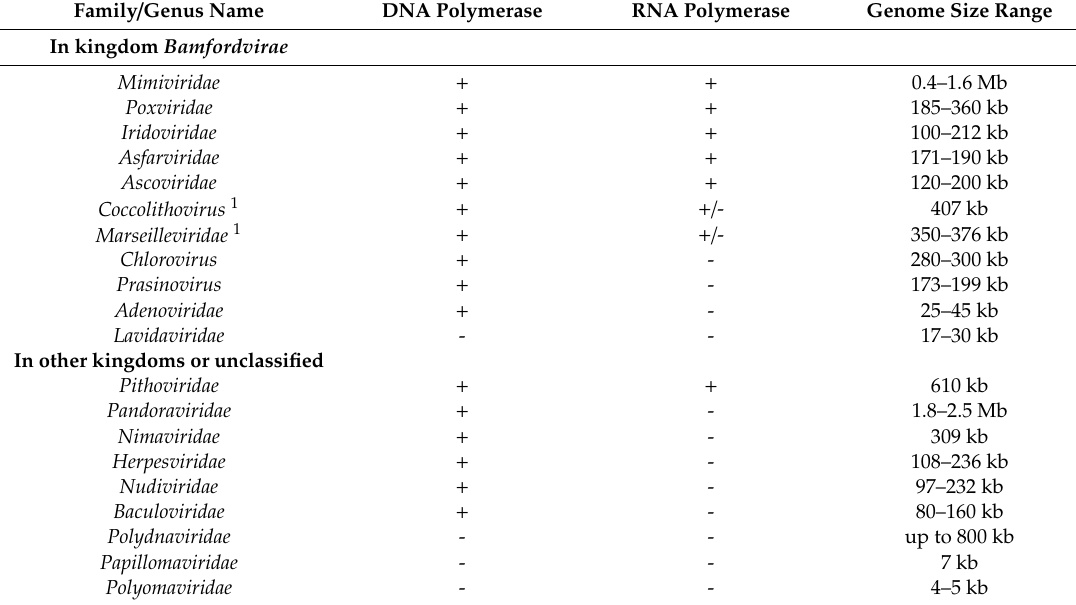
Table 1. Virus-encoded DNA / RNA polymerases in various eukaryotic dsDNA viruses. Family / Genus Name DNA